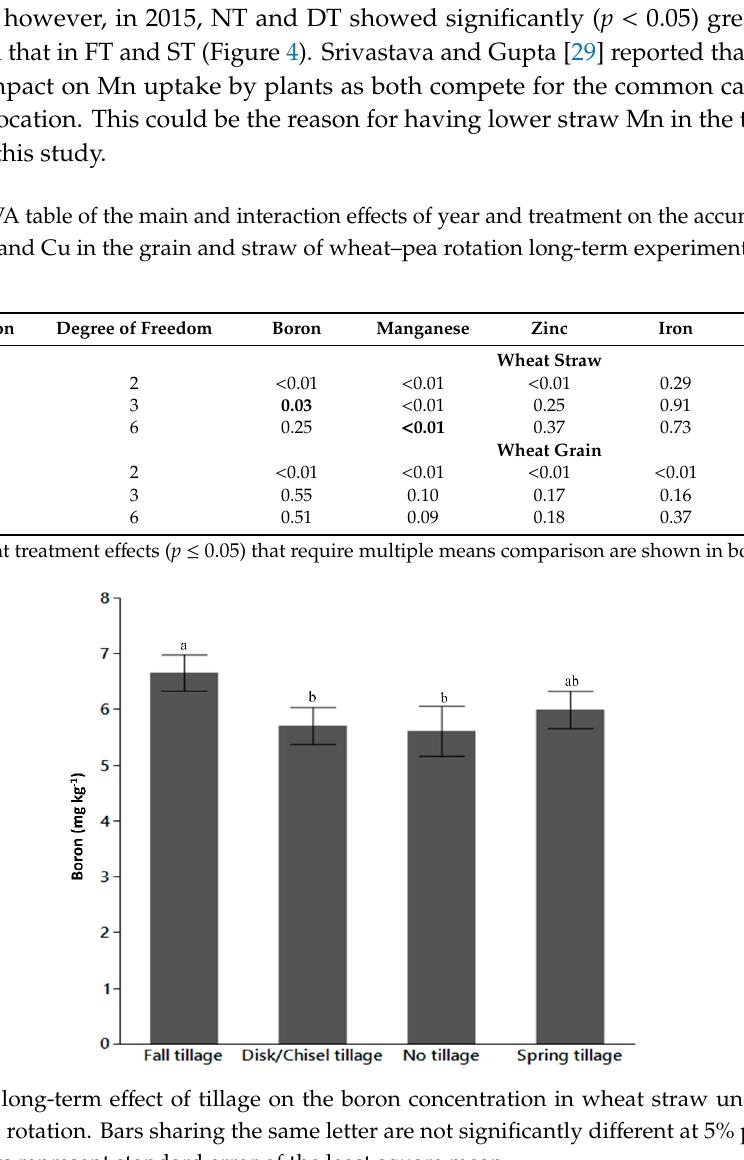
Figure 4. Effect of tillage methods on the concentration of manganese in wheat straw over the 20-year time period. Letters above the bars show a comparison of 12 combinations of treatment and year. Bars sharing the same letter are not significantly different at 5% probability level. Error bars represent the standard error of the least square mean. 4. Conclusions